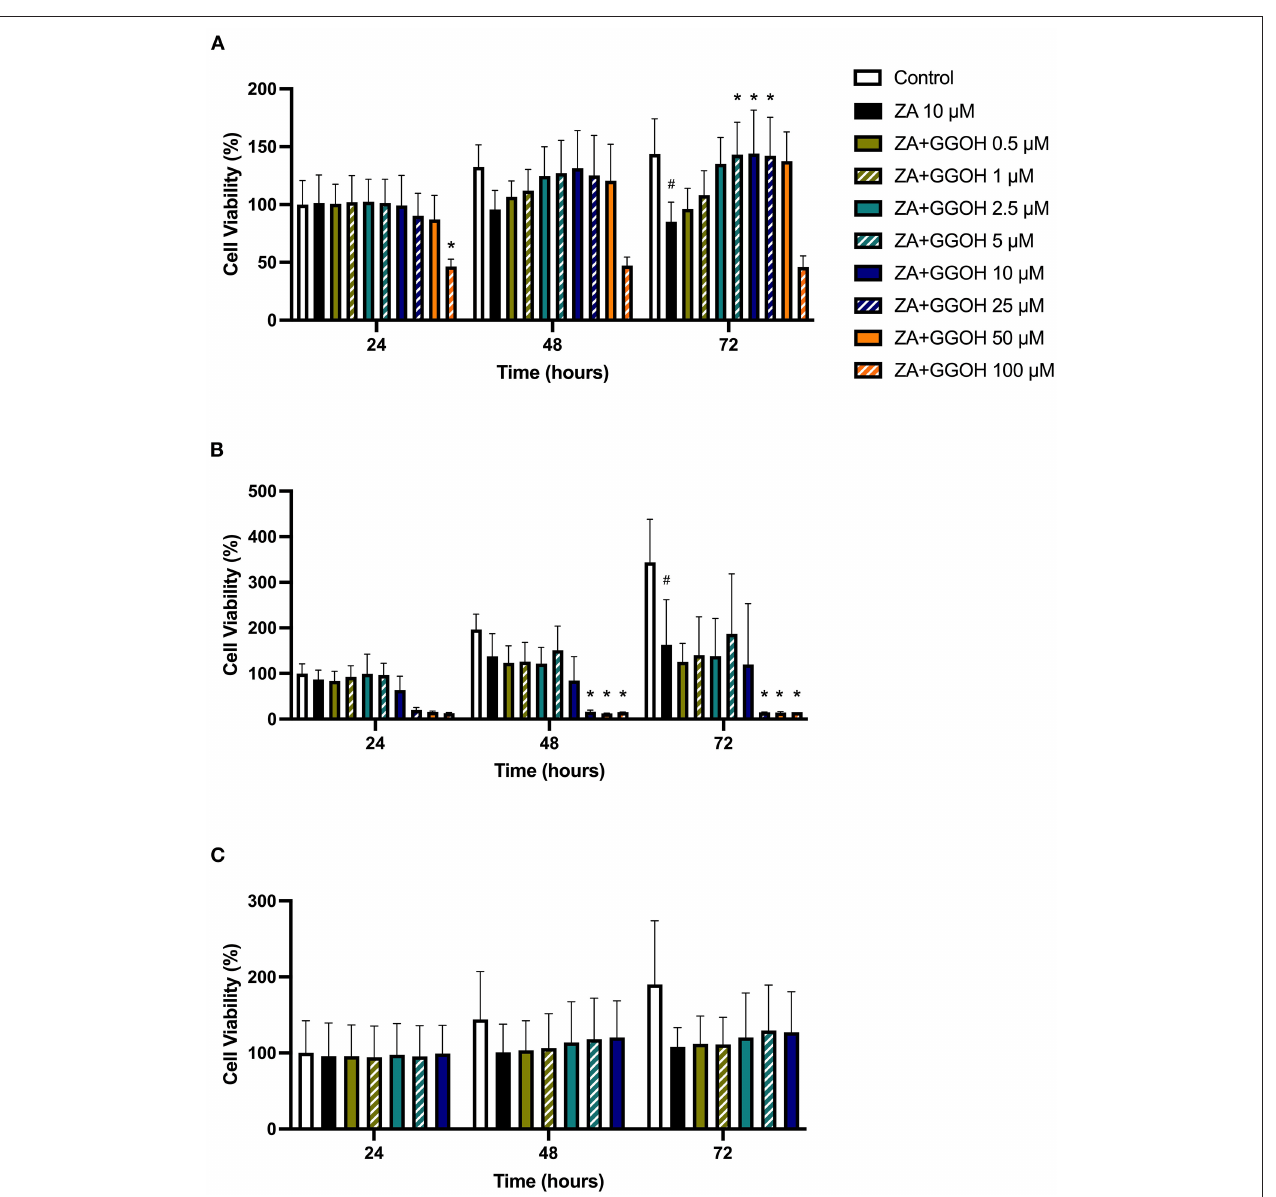
FIGURE 5 | (A) NOF (B) OKF6/TERT-2 (C) NOK viability in the presence of different GGOH concentrations in combination with ZA for 72h. All N = 3 except control, ZA, and ZA+GGOH 10 µ M of (B) , N = 6. Mean + / − standard deviation (SD). # shows statistical significance (p < 0.05) in comparison to untreated control and * shows statistical significance (p < 0.05) between 10 µ M ZA group and test